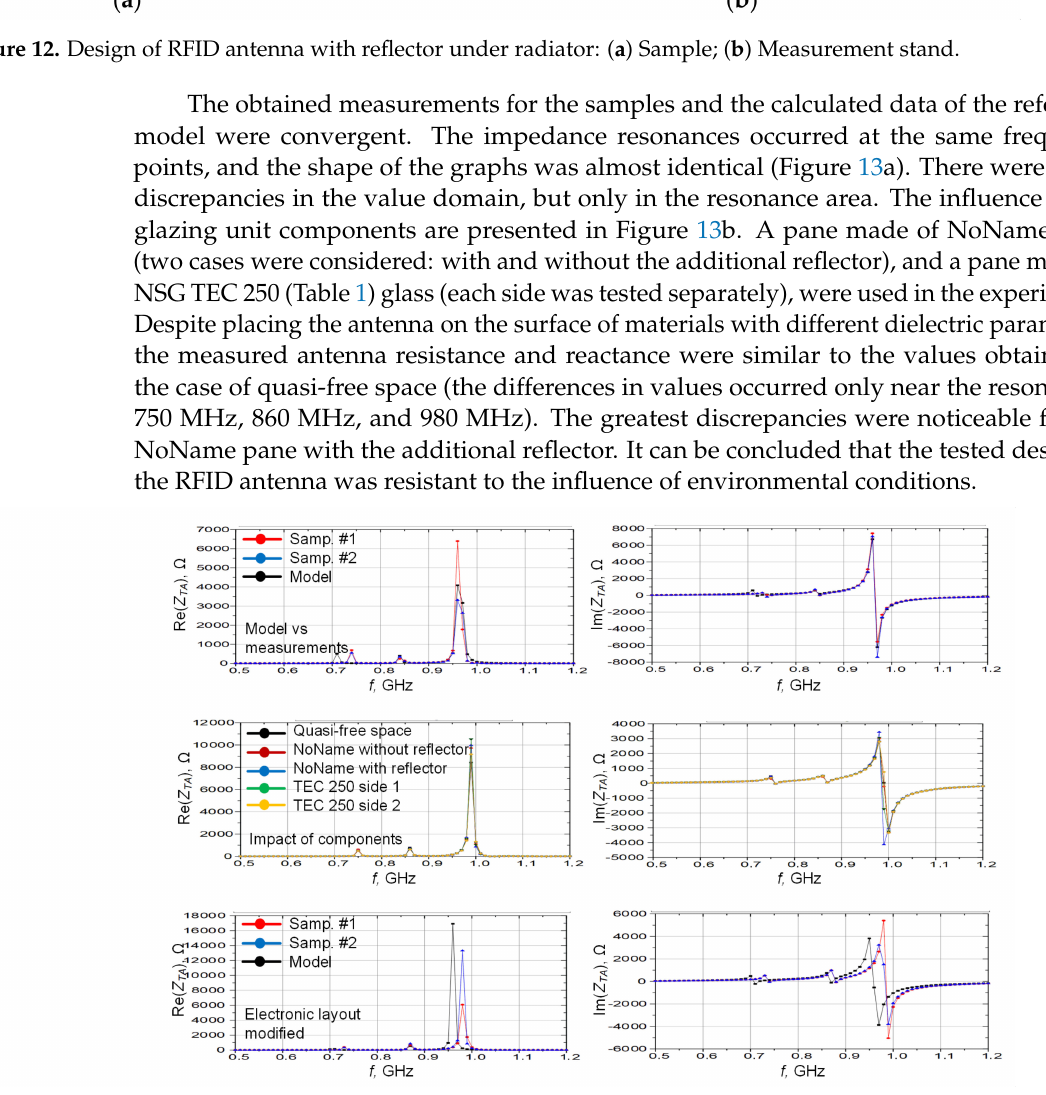
Figure 13. Impedance of RFID monopole antenna: ( a ) Calculations and measurements comparison; ( b ) Influence of glazing unit components; ( c ) Negative impact of changes in geometric dimensions of